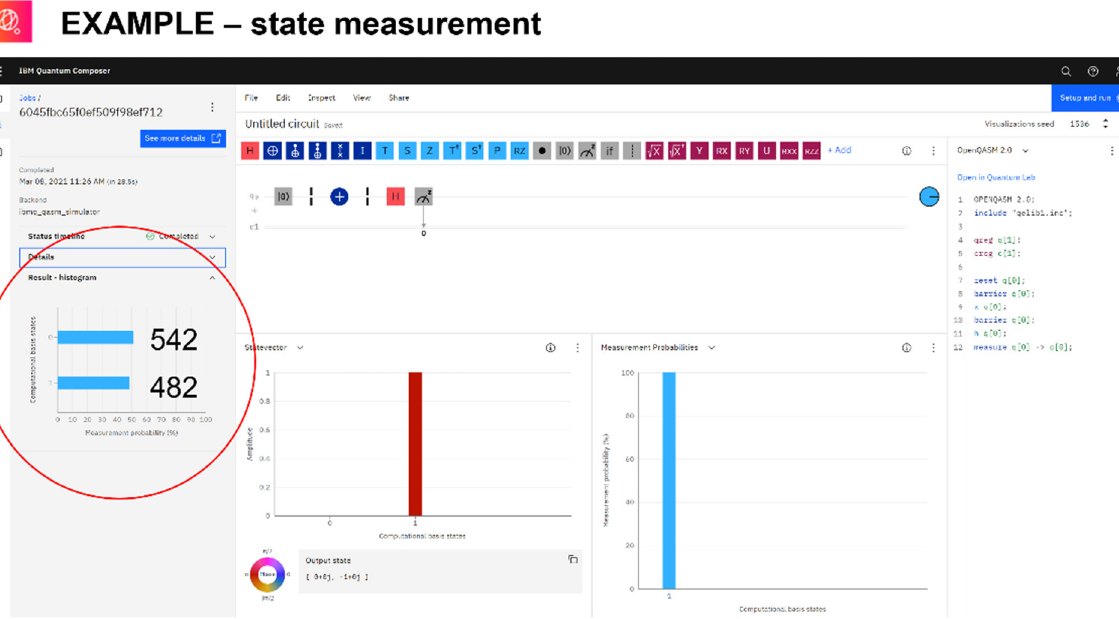
Figure 3. Second lecture: IBM Q-composer interface for programming quantum computers. Example of the quantum coin flip circuit executed on a simulator. In the Q-composer interface, |0 ⟩ and |1 ⟩ are the kets representing the computational basis. Center of the graphic interface. Top : the row of symbols represents a number of quantum logic operators (quantum gates) that can be picked up to compose the quantum circuit. Middle : below the list of operators is the composed circuit: here, to the |0 ⟩ state an X-not gate (represented by the plus symbol) is applied, followed by an Hadamard gate (H symbol) and a measurement operation (gauge symbol). Bottom : representation of the state vector in terms of probability and in the Bloch sphere representation ( left ) and of the measurement probabilities ( right ). A single measurement yields just one of the possible outcomes (1 in this case). The left part of the graphical interface shows an output of a repeated measurement yielding a statistical distribution of the two possible outcomes (in the red circle). The right part of the interface shows Python code corresponding to the quantum circuit. Credits: IBM Q-composer [21].